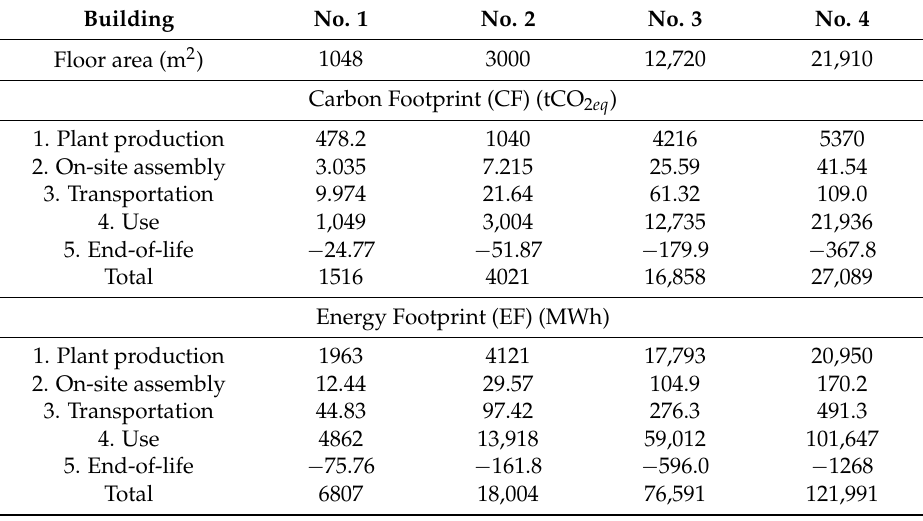
Table 3. Carbon and Energy Footprint of the four selected buildings for the reference